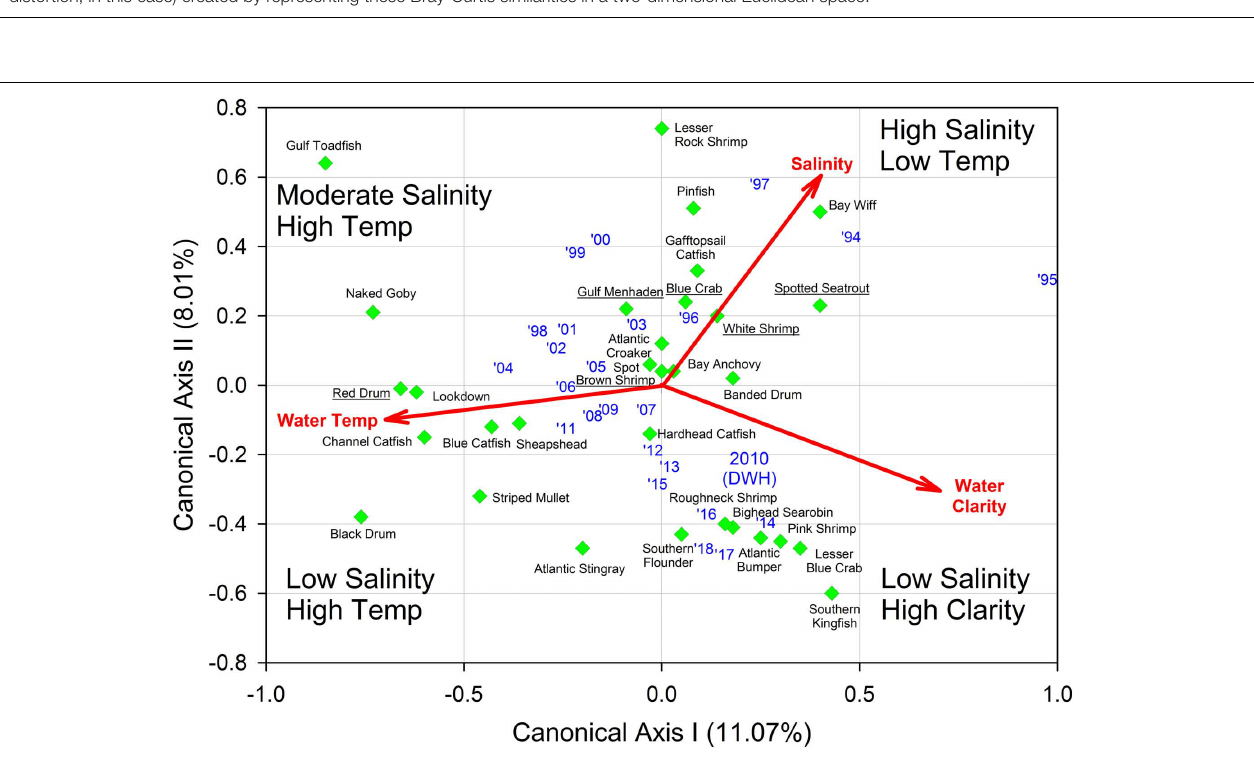
FIGURE 7 | Results of multivariate redundancy analysis (RDA) relating three important environmental variables (salinity, water temperature, water clarity) to relative fish and invertebrate abundance from Barataria Bay trawl surveys, 1994–2018. Blue texts are individual years. Common names of the “key species” are underlined. Data were analyzed from the Louisiana Department of Wildlife and Fisheries trawl